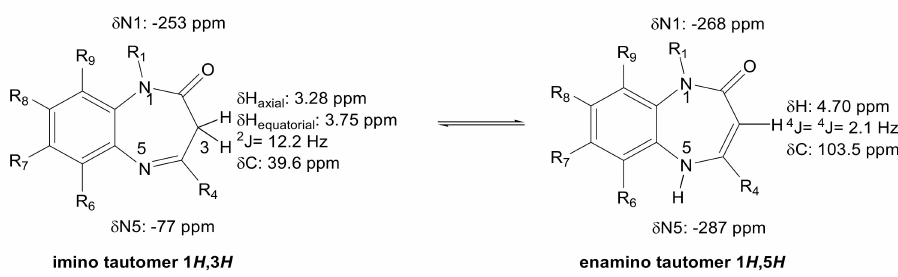
Figure 4. 1 H, 13 C and 15 N NMR data differentiating the imino and enamino tautomers of 1,5-benzodiazepin-2(3H)-ones.